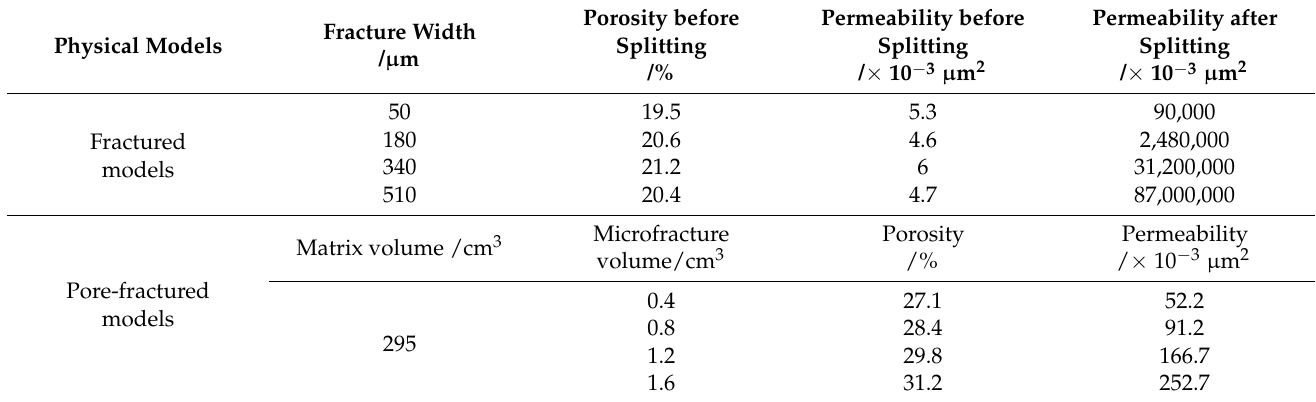
Table 2. Basic parameters of the fractured and pore-fractured experimental models.